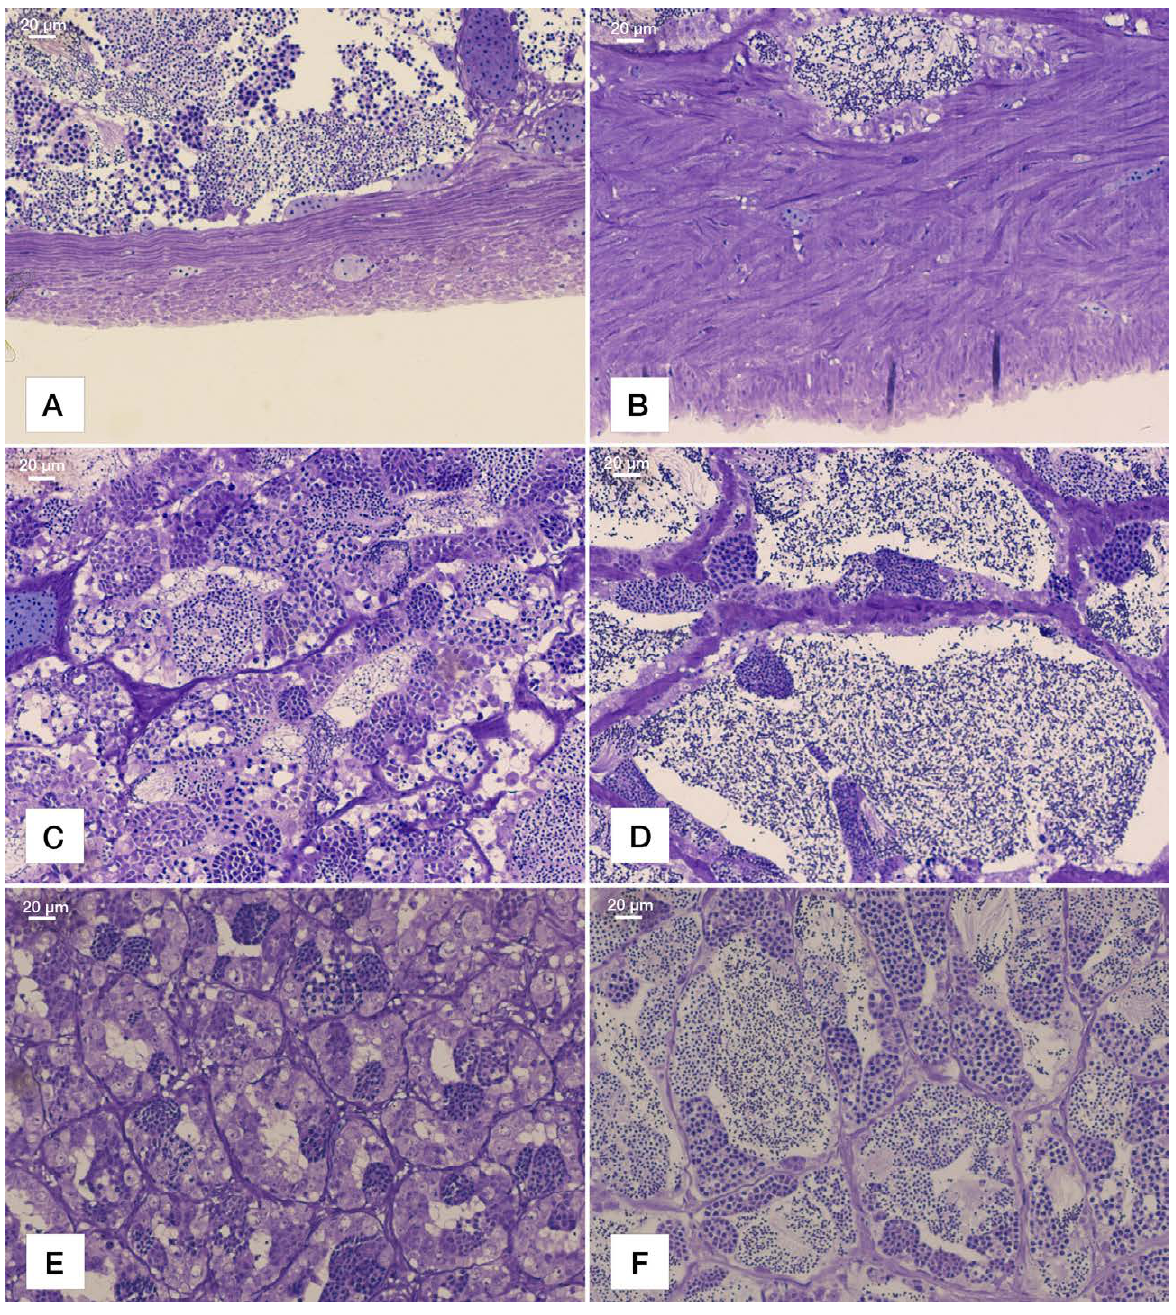
Fig. 6. – Details of month-related and size-related variability in the testes of meagre [TL, total length in cm; M, month of capture; P, place of capture, southern coast (SC) or Tagus Estuary (TE); H, Histological stage]. A, thin wall during spawning months [TL, 140; M, April; P, SC; H, spawning-capable]; B, thick wall characteristic of post-spawning [TL, 148; M, June; P, SC; H, regressing]; C, thin connective tissue form- ing the lobular walls [TL, 144; M, March; P, SC; H, developing]; D, thickened connective tissue [TL, 177; M, June; P, SC; H, regressing]; E, compact appearance with no sperm present [TL, 56; M, June; P, TE; H, developing]; F, compact appearance with sperm present [TL, 44; M, June; P, TE; H, spawning-capable]. Scale bar, 20 μm, 200 ×